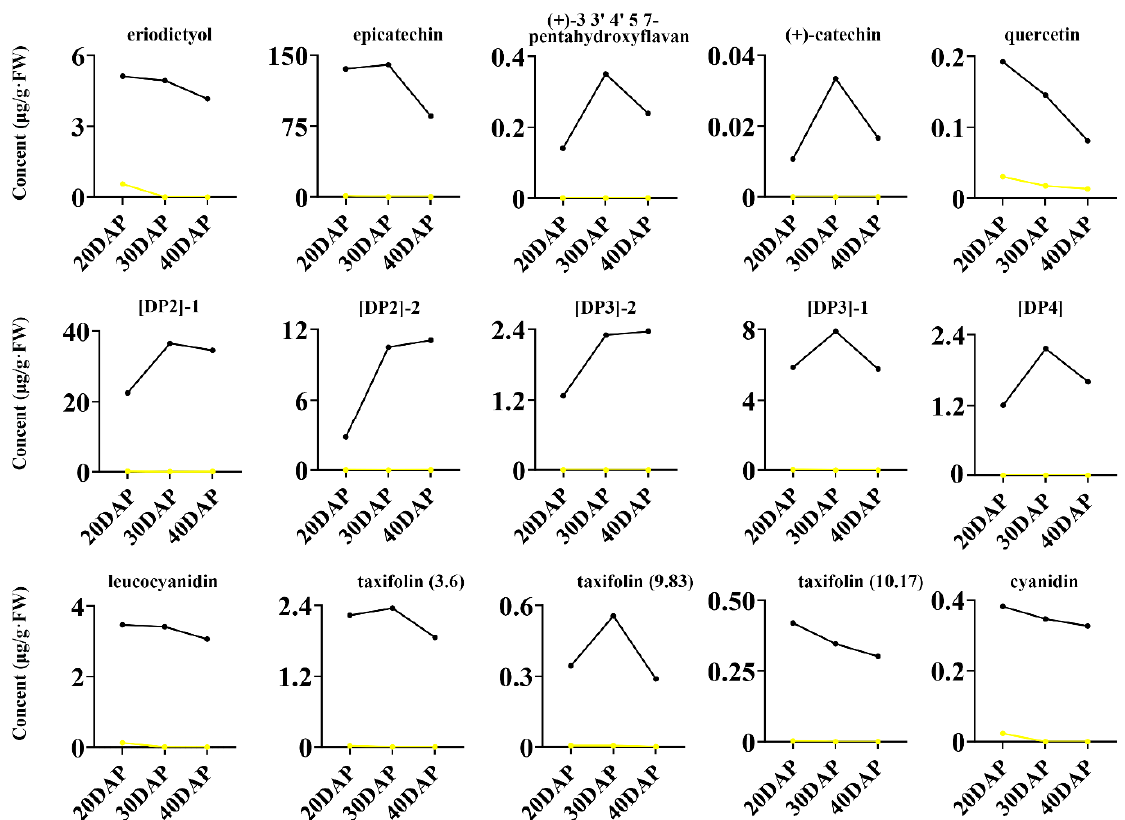
Figure 4. Qualitative and quantitative analysis of the common differentially abundant metabolites in yellow- and dark- seeded B. juncea . Accumulation of differentially abundant metabolites during seed development in yellow- and dark-seeded B. juncea . The black and yellow lines represent dark- and yellow-seeded B. juncea , respectively. The title number represents the code of proposed compounds and the related information is listed in Supplementary Table S1. DAP, days after pollination. DP2, procyanidin B; DP3, procyanidin C; DP4, procyanidin D.